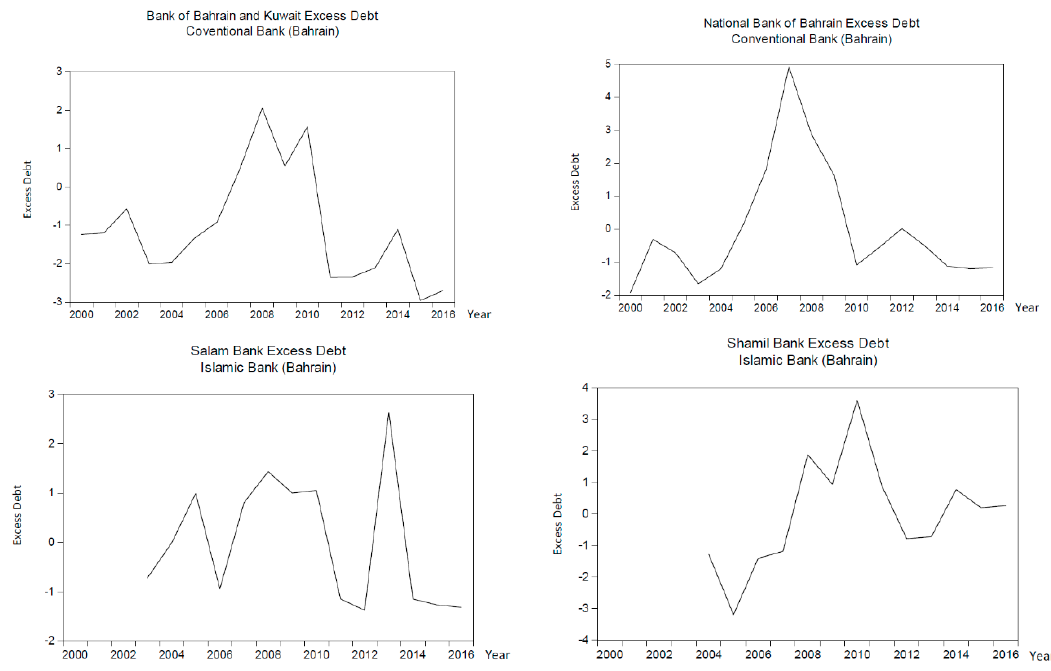
Figure 6. Bahrain excess debt. Source: Author’s calculations.